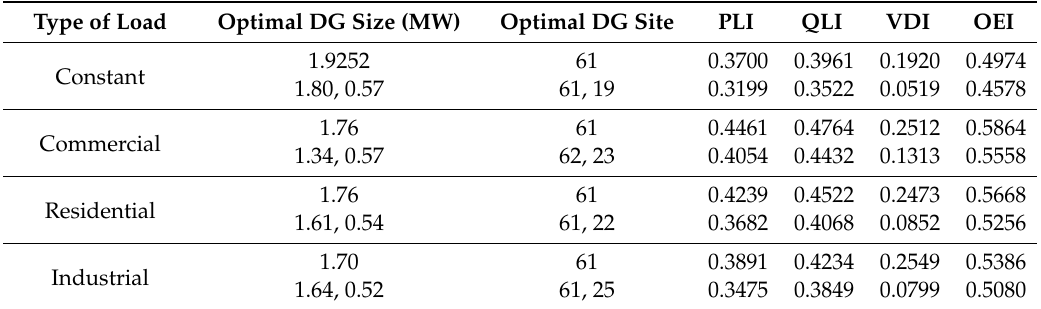
Table 3. Optimal size and site of DG and Indices values for reactive power loss index (QLI) as objective. Type of Load